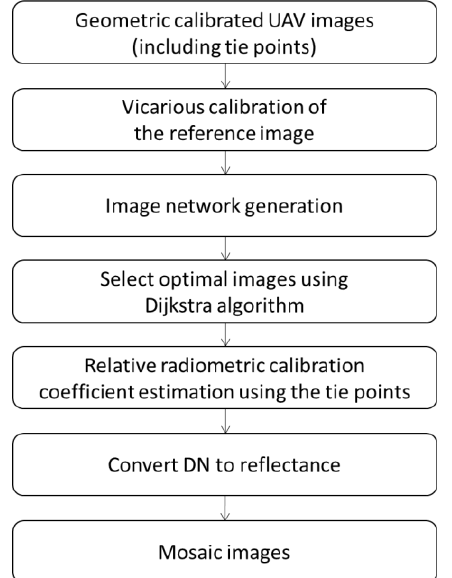
Figure 5. Overall procedure of radiometric calibration